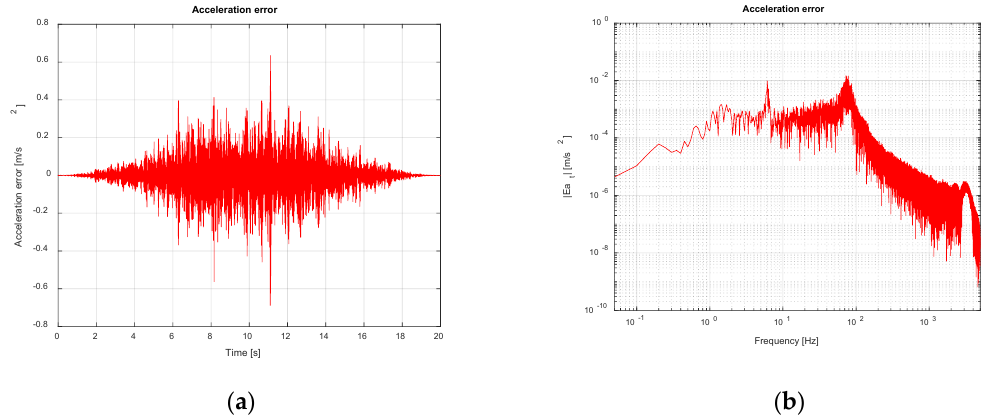
Figure 21. Shake table acceleration error (noise-free scenario). TVC Enabled: ( a ) Time domain; ( b ) Frequency domain.